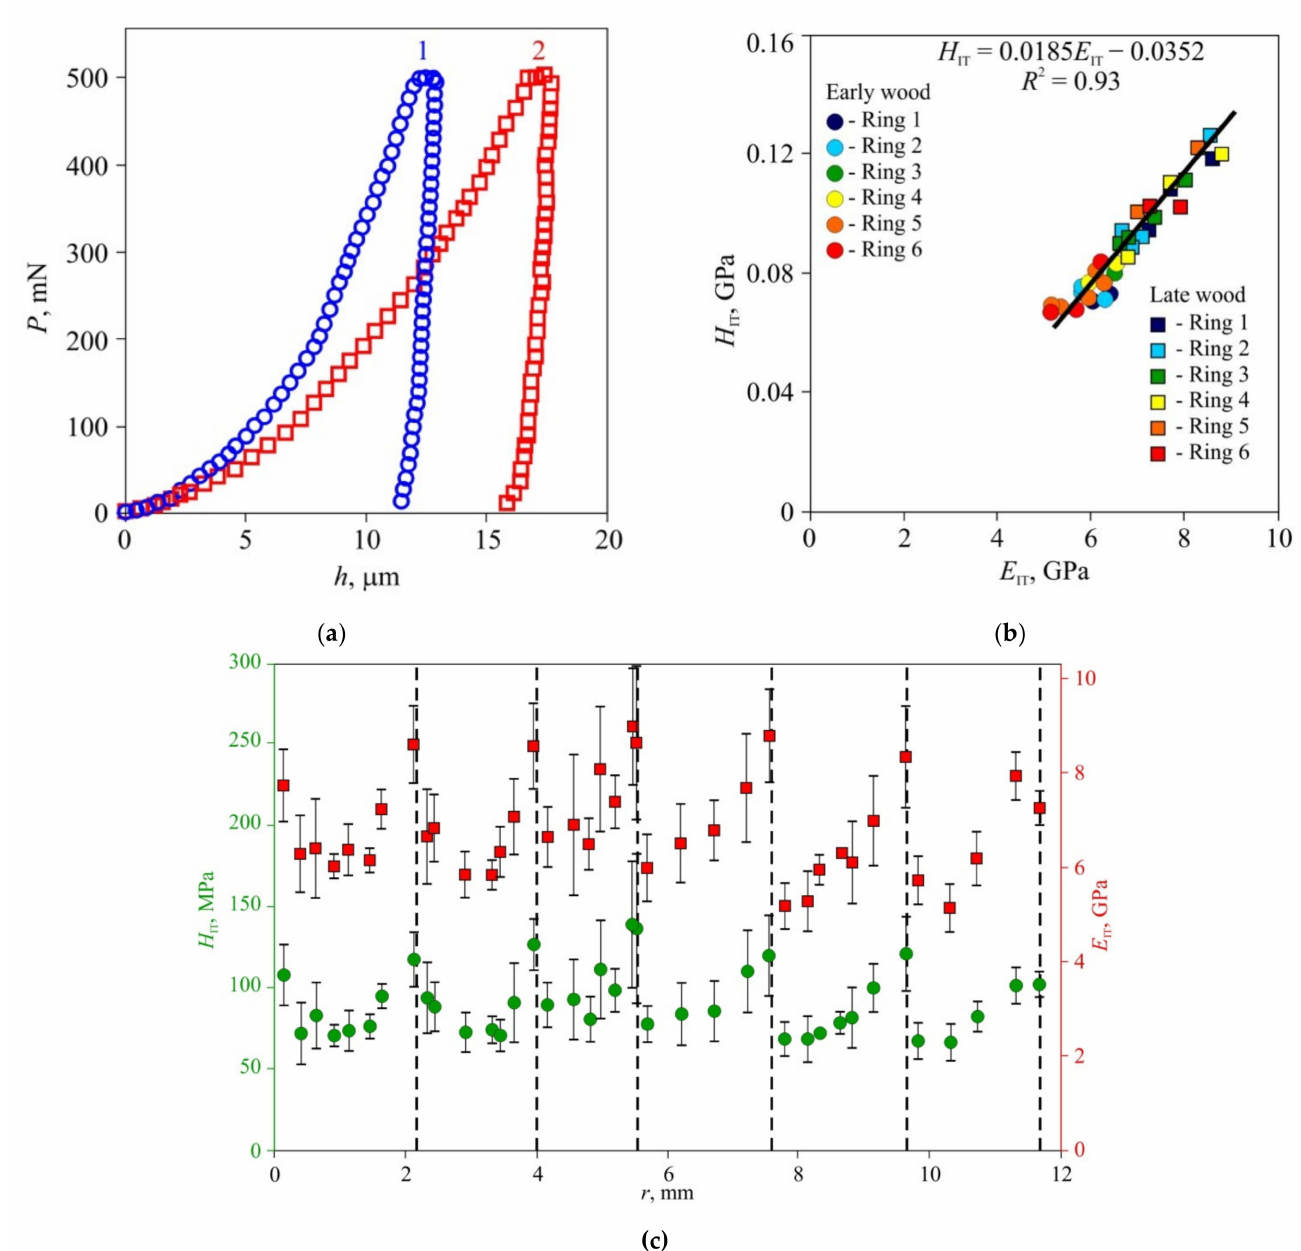
Figure 8. Effective microhardness H IT and Young’s modulus E IT in annual rings of lime wood, ( a ) Typical P–h diagrams for late (1) and early (2) wood; ( b ) dependence of hardness H IT upon Young’s modulus E IT for seven sequential growth rings; ( c ) spatial distribution of hardness H IT and Young’s modulus E IT across sequential growth rings r . The positions of ring boundaries are shown by dashed